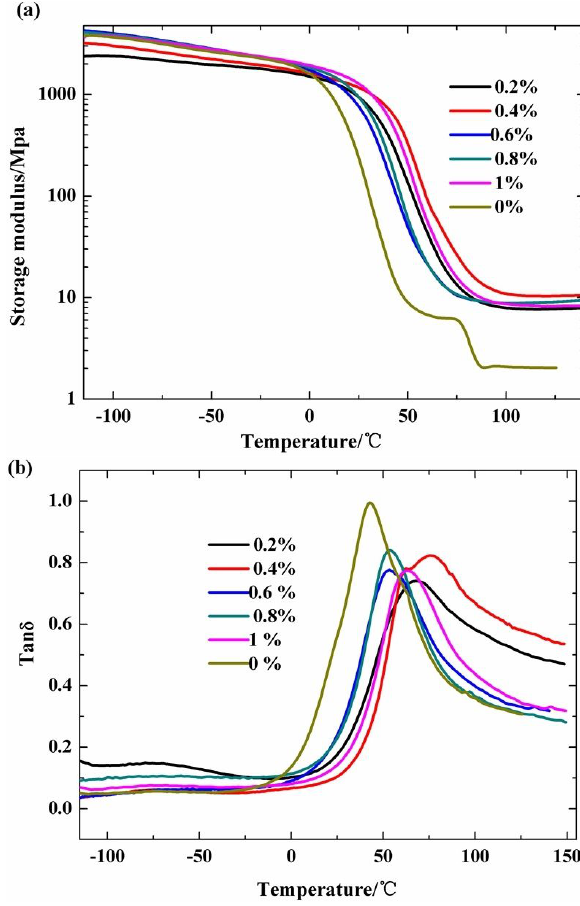
Figure 6: (a) DMA storage modulus vs. temperature at 1 Hz and (b) the corresponding tan δ of polyurethane/silicon oxide nano- composite coatings.